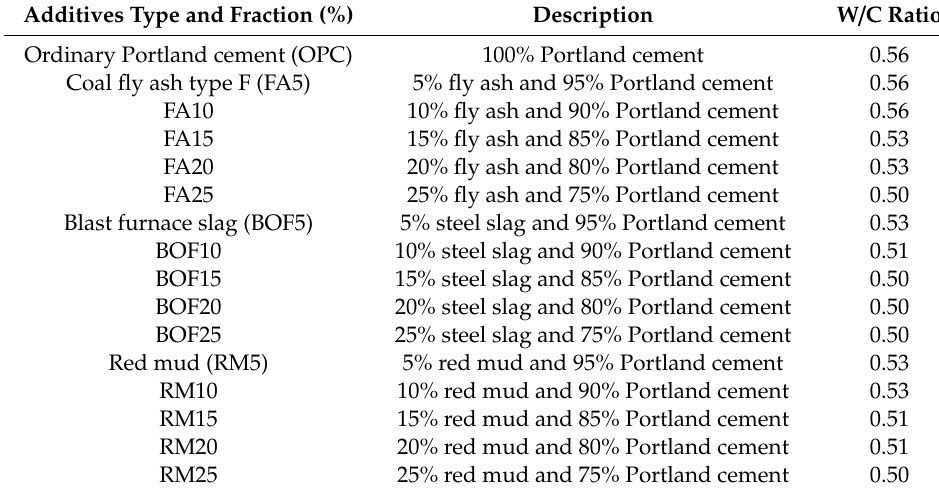
Table 2. Specimen description and water / cement